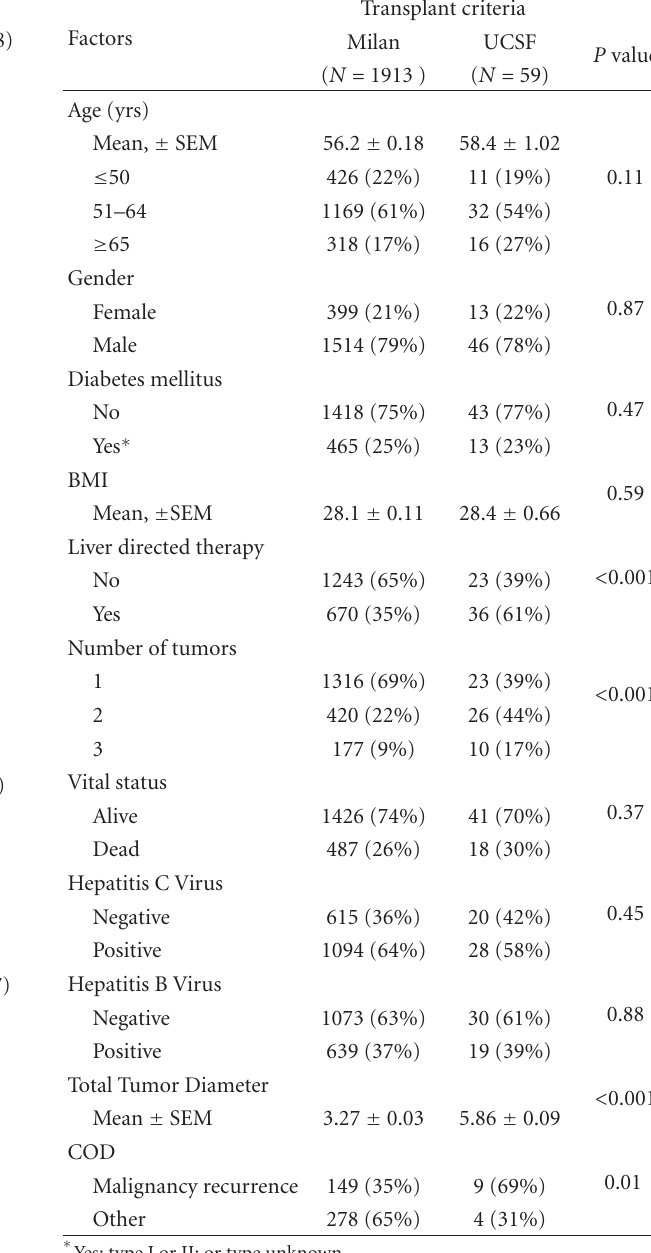
Table 1: Characteristics of patients within the cohort. Clinicopathologic factors